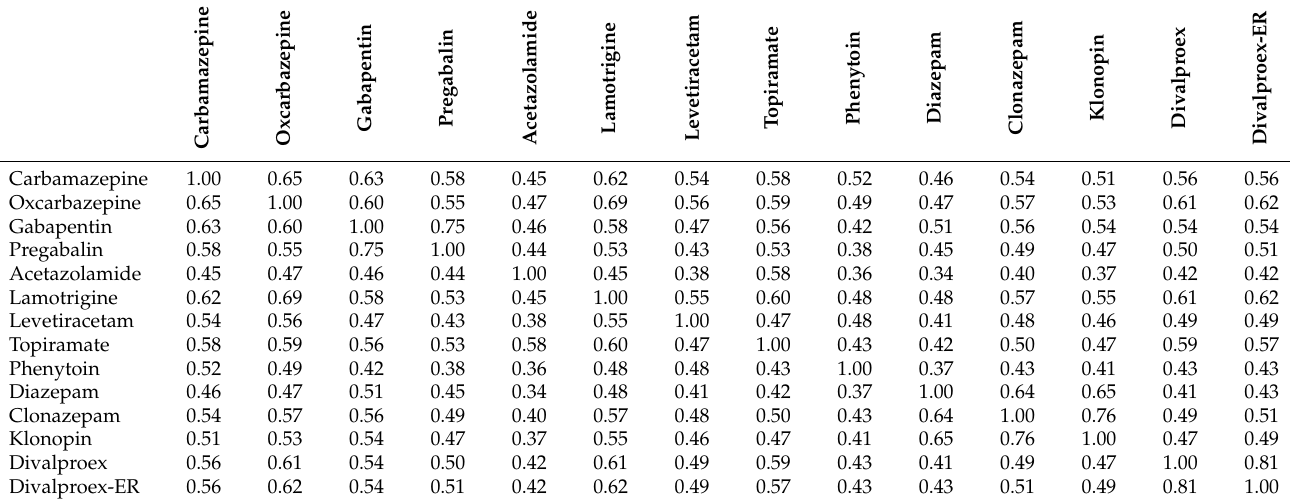
Table 2. TAEDs Drug-Drug Similarity using CS Measure.